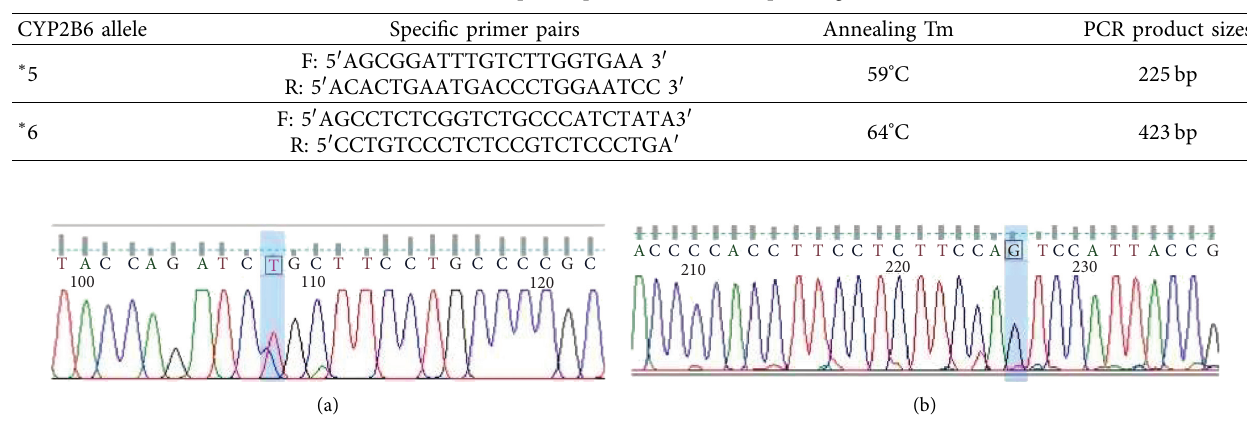
Figure 1: The restriction analysis result for CYP2B6 ∗ 4, ∗ 5, and ∗ 6 variants in Mazani ethnic group people. StyI enzyme cuts the normal variant to 56, 116, 171, and 297bp and mutated allele of ∗ 4 to 56, 116, and 468bp. BglII does not cut the normal variant (600bp) and just make the mutant ∗ 5 allele to 96 and 504bp. Finally, BsrI digest the normal variant to 28, 105, 268bp and ∗ 6 allele to 28 and 373bp. Table 2: Specific primers for PCR sequencing.